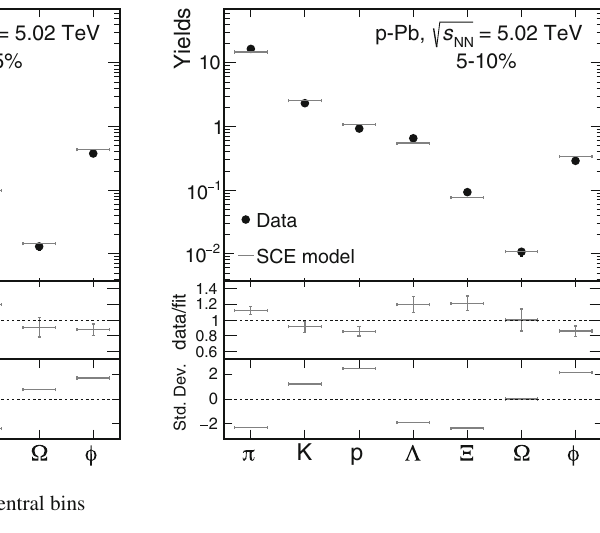
Fig. 1 The ratios of strange particle yields to pion yields, normalized to the corresponding value at the highest multiplicity, as a function of (cid:7) dN / d η (cid:8) | η | < ch 0 . 5 for p – Pb collisions at 5.02 TeV, left as measured, right scaled with a power determined by the number of strange and antistrange quarks in the hadron